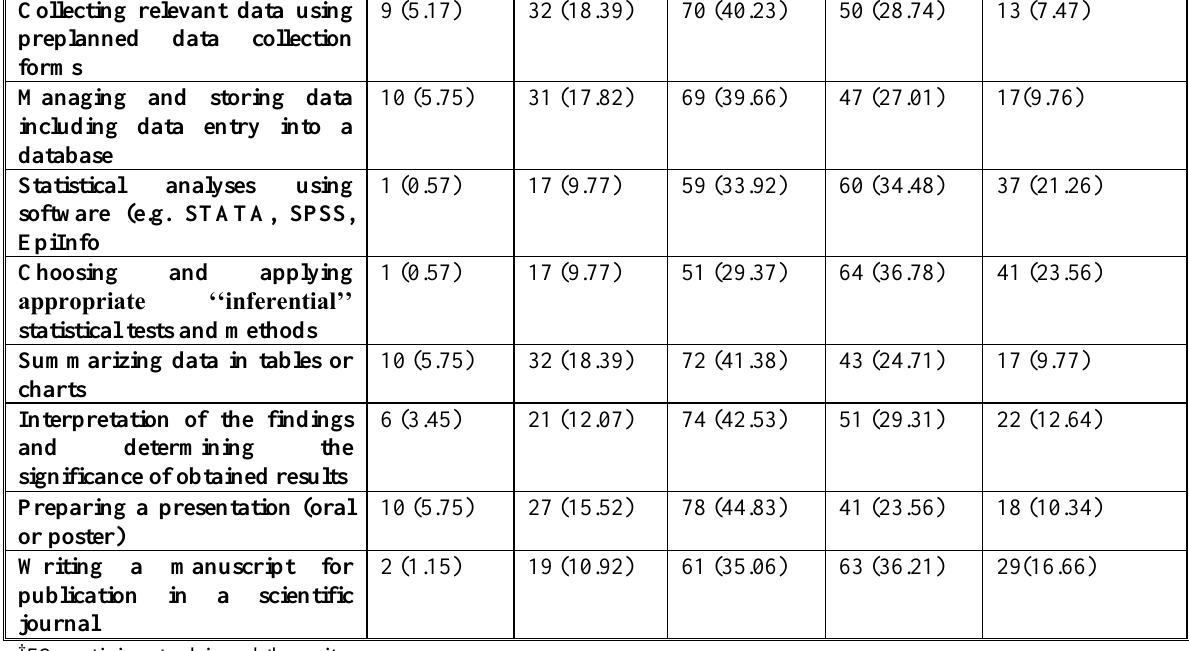
Table 5 .Pharmacists’ interest in